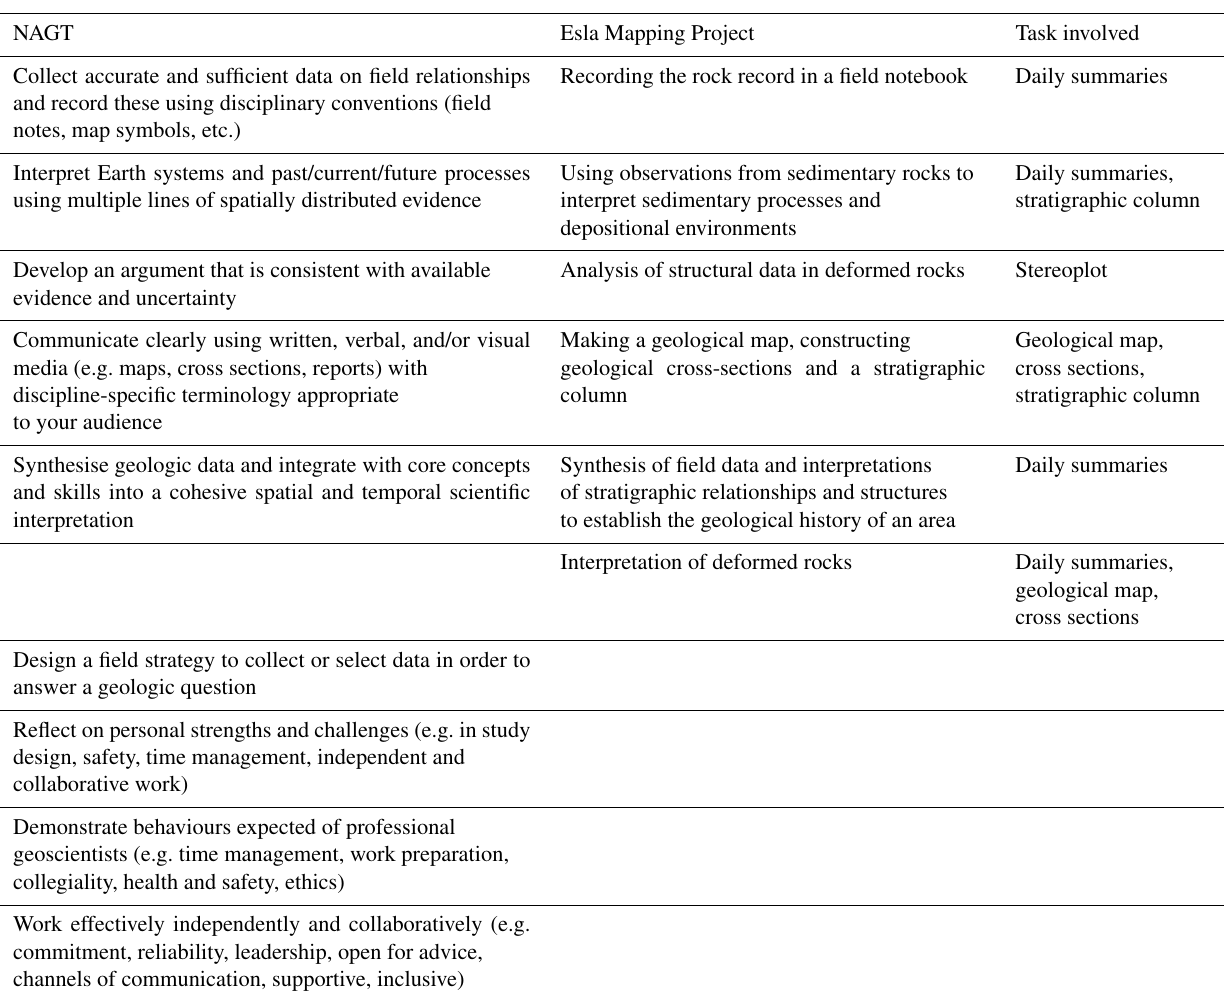
Table 1. Learning outcomes from the National Association of Geoscience Teachers (NAGT) for virtual field experiences and for the Esla Mapping Project, indicating the tasks in which they are